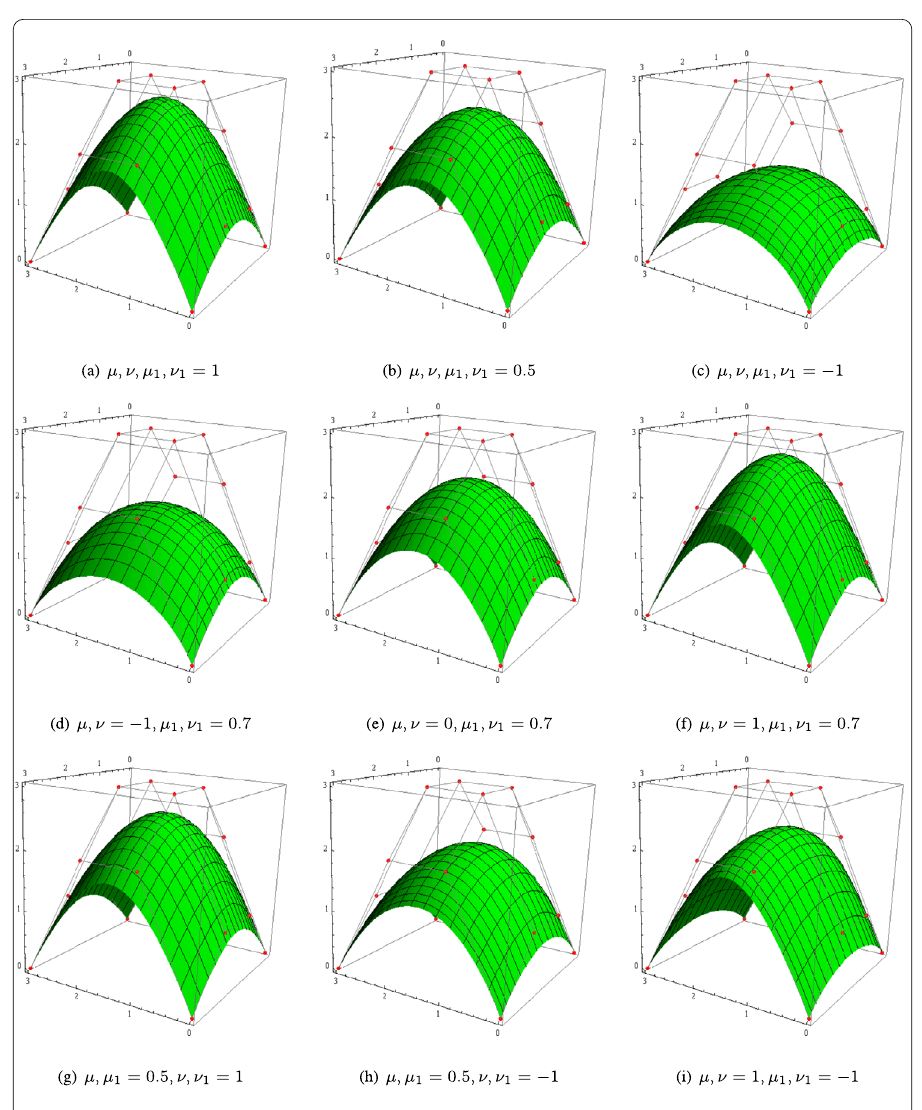
Figure 3 Effect of shape parameters on bi-cubic GBT-Bézier surfaces